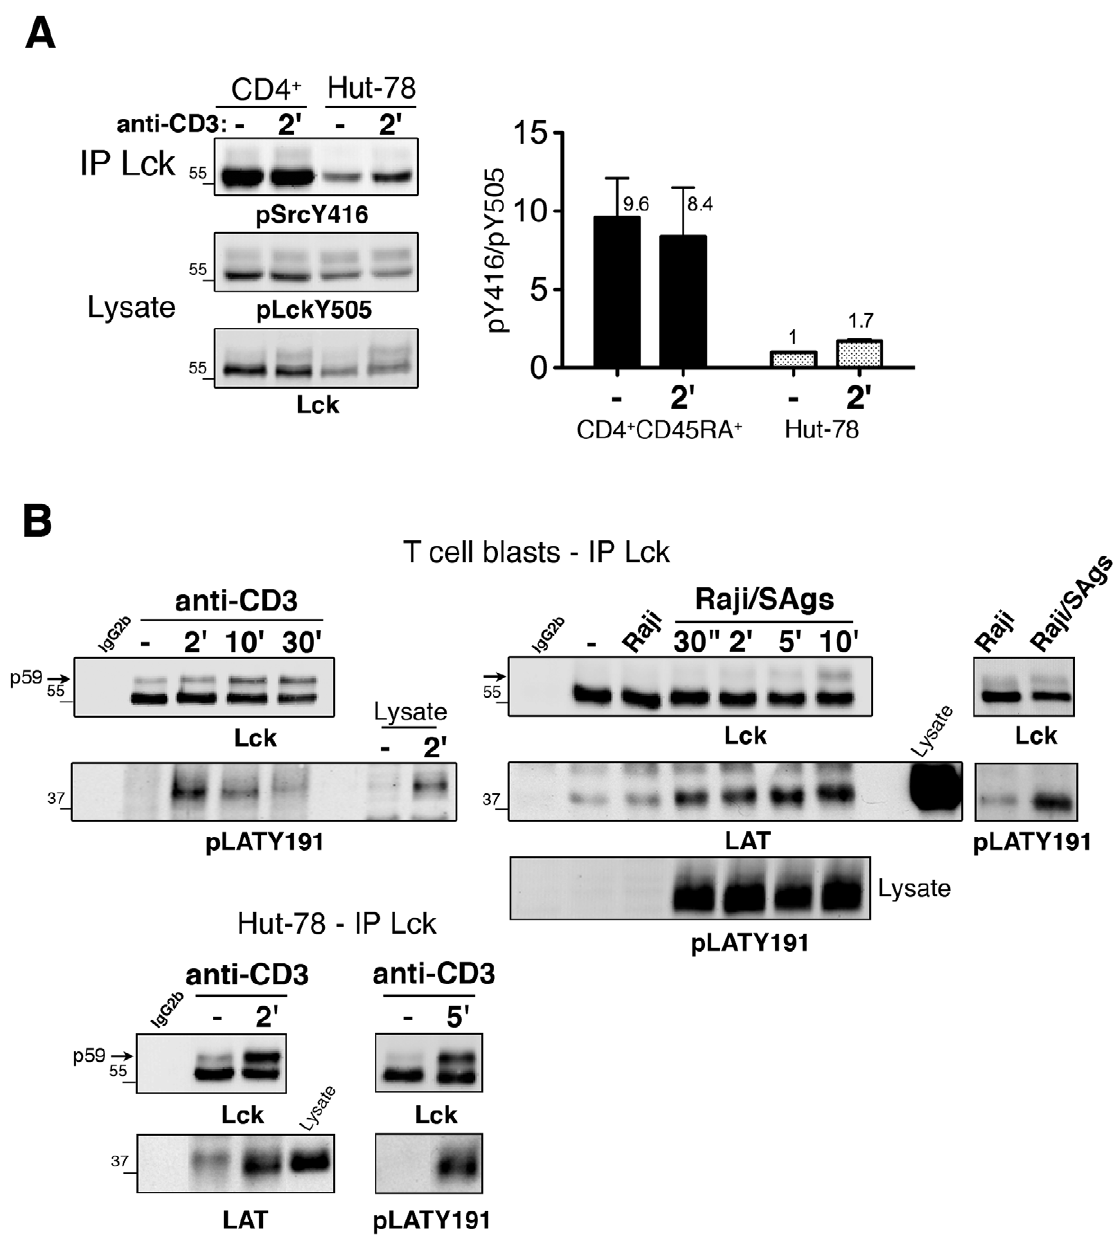
Figure 2. Lck phosphorylation and association to LAT in naı¨ve CD4 + T cells and Hut-78 cells. (A) Naı¨ve CD4 + CD45RA + T cells and Hut-78 cells were stimulated with anti-CD3 for 2 min. Left panel, Lck IPs (150 m g proteins) were analyzed for Tyr394 phosphorylation by immunoblotting with anti-pSrcY416. An aliquot of cell lysates was probed with anti-pLckY505 then with anti-Lck. The histogram shows the mean ratio of phospho-LckY394/ phospho-LckY505 + / 2 SD, from three donors, after normalization of signals to Lck. (B) Lck IPs from T cell blasts stimulated for the indicated times with anti-CD3 or Raji/SAgs (2 min, right panels) were analyzed for LAT co-precipitation by immunoblotting with anti-pLAT-Y191 (left and right panels) and anti-LAT (middle panels). The kinetics of LAT phosphorylation on Tyr191 is shown in cell lysates from superantigen-stimulated T cells. Lck IPs from Hut-78 cells stimulated by CD3 crosslinking were probed with anti-LAT and anti- pLAT-Y191 (lower panels). IgG2b corresponds to lysates from TCR- stimulated cells for 2 min incubated with beads coated with isotype control IgG2b. Assays in B were performed with six donors and at least three times with Hut-78 cells. doi:10.1371/journal.pone.0015114.g002 phosphorylated Lck/Fyn doublet increased at 2 min, with the upon transient RNAi of LAT expression (Figure 3A). Hut-78 cells, transfected with siRNA against LAT (siLAT), exhibited , 80% phosphorylated p59 form persisting at 5 and 10 min. Surprisingly, LAT knockdown efficiency and , a 60% reduction in TCR- in TCR-stimulated LAT knocked-down cells, the phosphorylation mediated phosphorylation of PLC c 1, a direct partner of LAT of Lck/Fyn doublet was decreased of , 10-25% (Figure 3A, right histogram). To achieve higher LAT silencing, Hut-78 cells were [6,7]. Cell lysates were immunoblotted with anti-pSrcY416 Abs. In TCR-stimulated control cells (siNeg), the level of basally stably knocked-down. Two Hut-shLAT clones (shLAT # 1,